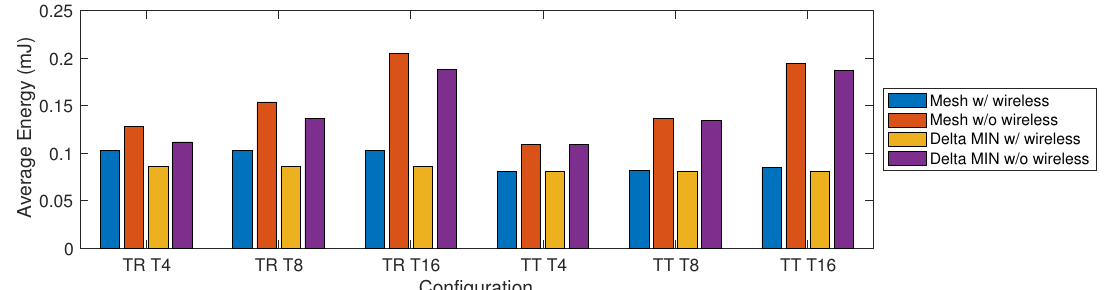
Figure 23. Average energy (mJ) in non-saturated conditions for Delta MIN and mesh topologies of size 64.